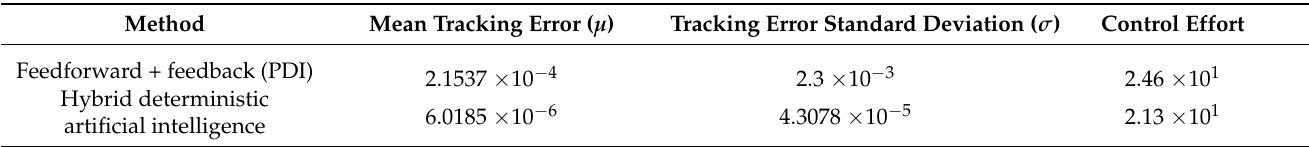
Table 7. Figures of merit for thirty-degree yaw with perturbations 1 .